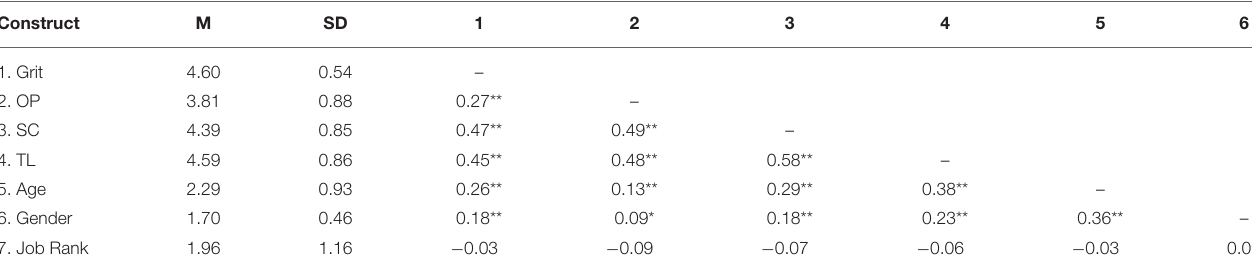
TABLE 1 | Estimated correlations among grit, OP, SC, TL, and demographic information scores.